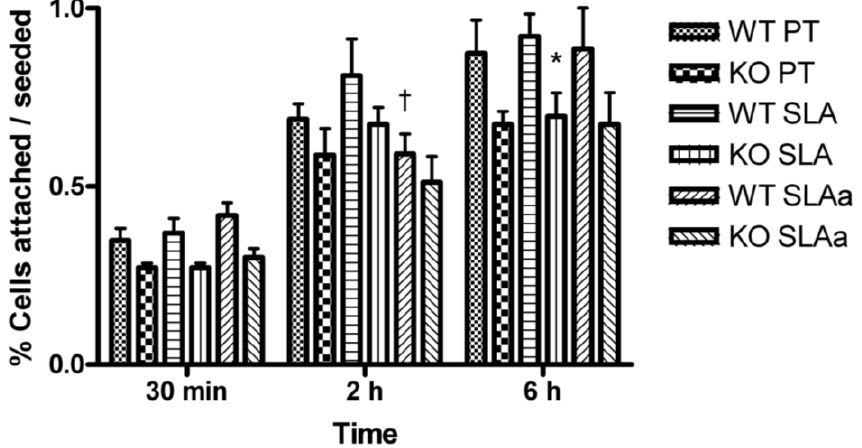
Figure 2. Influence of substratum topography and hydrophilicity on attachment of FAK −/− and WT fibroblasts to PT, SLA and hydrophilic SLA at 30 mins, 2 and 6 h